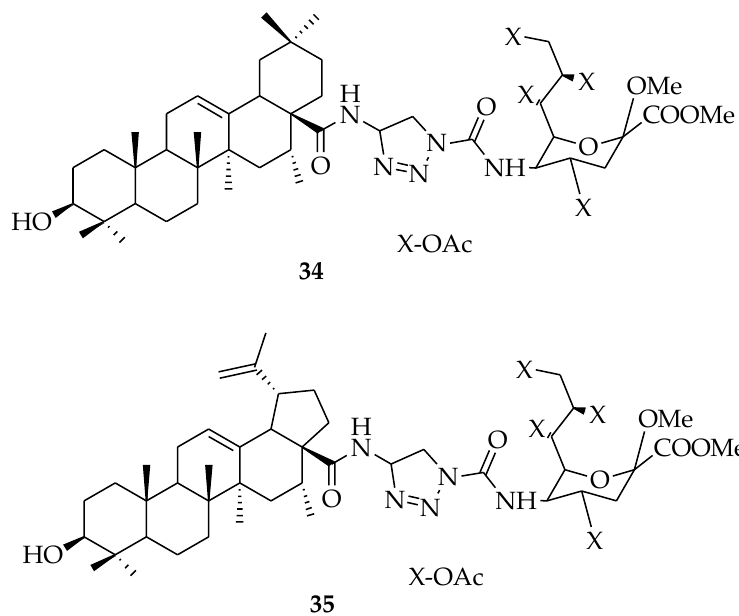
Figure 10. OA derivatives with anti-influenza activity.